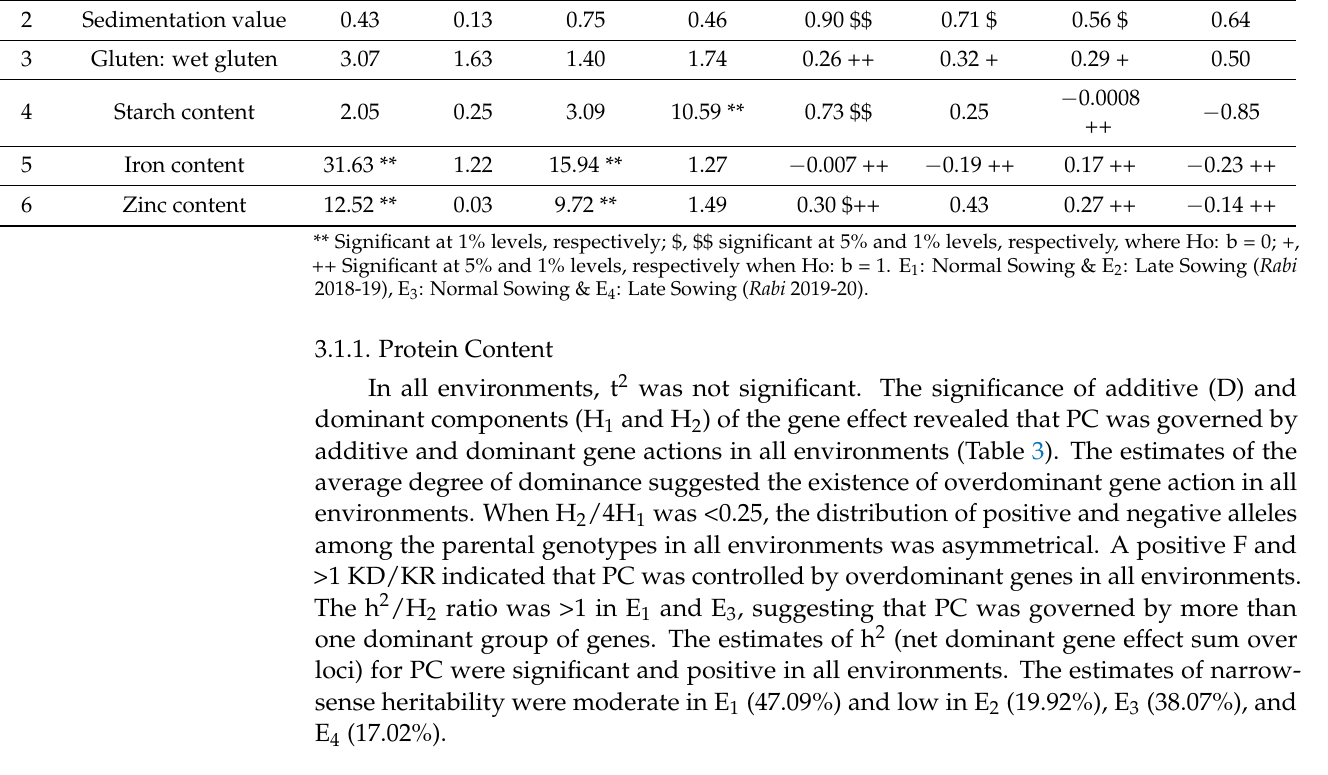
Table 3. Genetic components of protein content and sedimentation